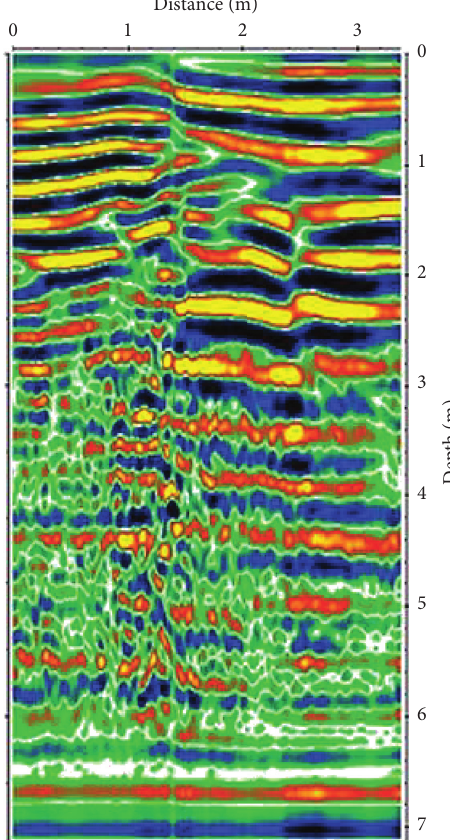
Figure 10: Radar data.